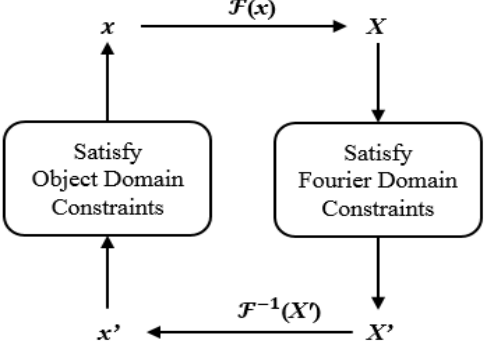
Figure 8. Gerchberg–Saxton phase retrieval algorithm.